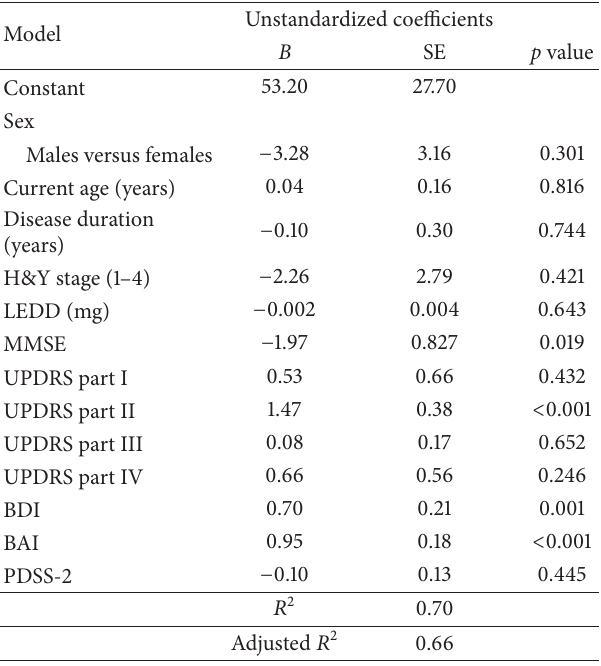
Table 5: Predictors of PDQ-39 in the forward multiple regression analysis (𝑁 = 134)